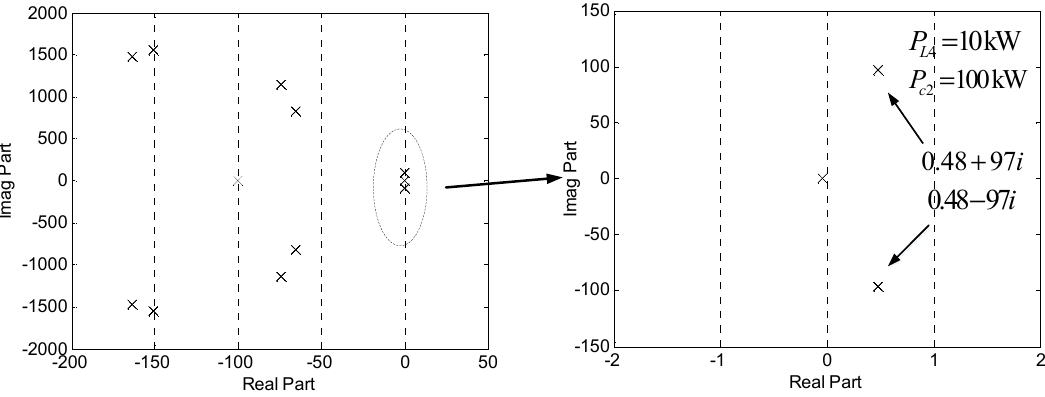
= 50 kW, P = 100 kW. Energies 2017 , 10 , 69 11 of 16 T when = . Figure 11. The dominant poles of T m when P L c 2 4 m